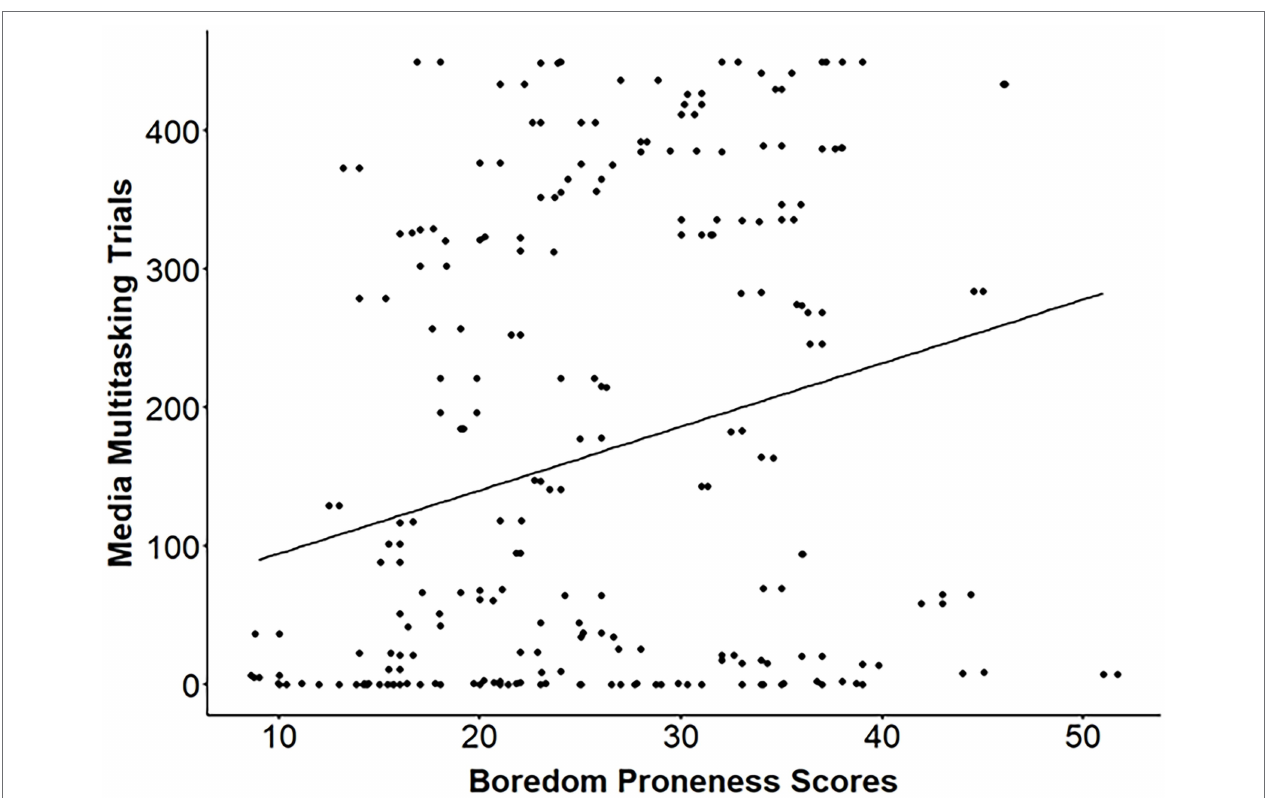
FIGURE 5 | Scatterplot illustrating the relationship between trait boredom proneness and the number of trials spent media multitasking.